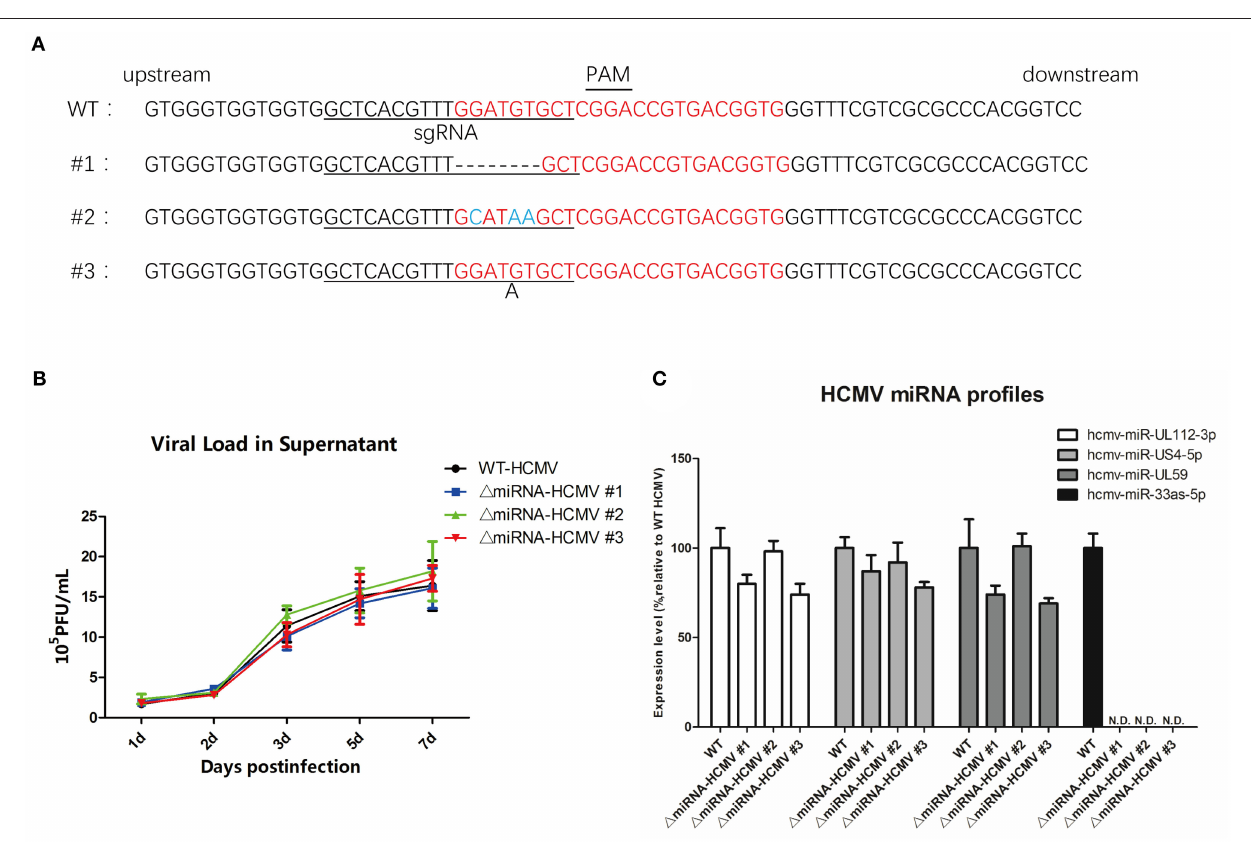
FIGURE 5 | CRISPR-Cas9 introduced mutations in hcmv-US33as-5p and did not obviously affect HCMV virology. (A) The DNA sequence surrounding the hcmv-US33as-5p editing region from each HCMV mutant strain was amplified by PCR and analyzed by DNA sequencing. The PAM sequence and sgRNA-targeting region are indicated with lines. The DNA sequence-editing miRNA bases are highlighted in red. Deletions and insertions are presented by dashed lines or a letter underneath the sequence, respectively. No mutations in the control samples were observed. (B) MRC-5 cells were infected with WT, 1 miRNA HCMV #1, 1 miRNA HCMV #2, or 1 miRNA HCMV #3 at an MOI = 1, and the viral loads from the supernatants at 1d, 2d, 3d, 5d, 7d were determined by qPCR. (C) The expression of several miRNAs encoded by HCMV at 72 hpi was examined by